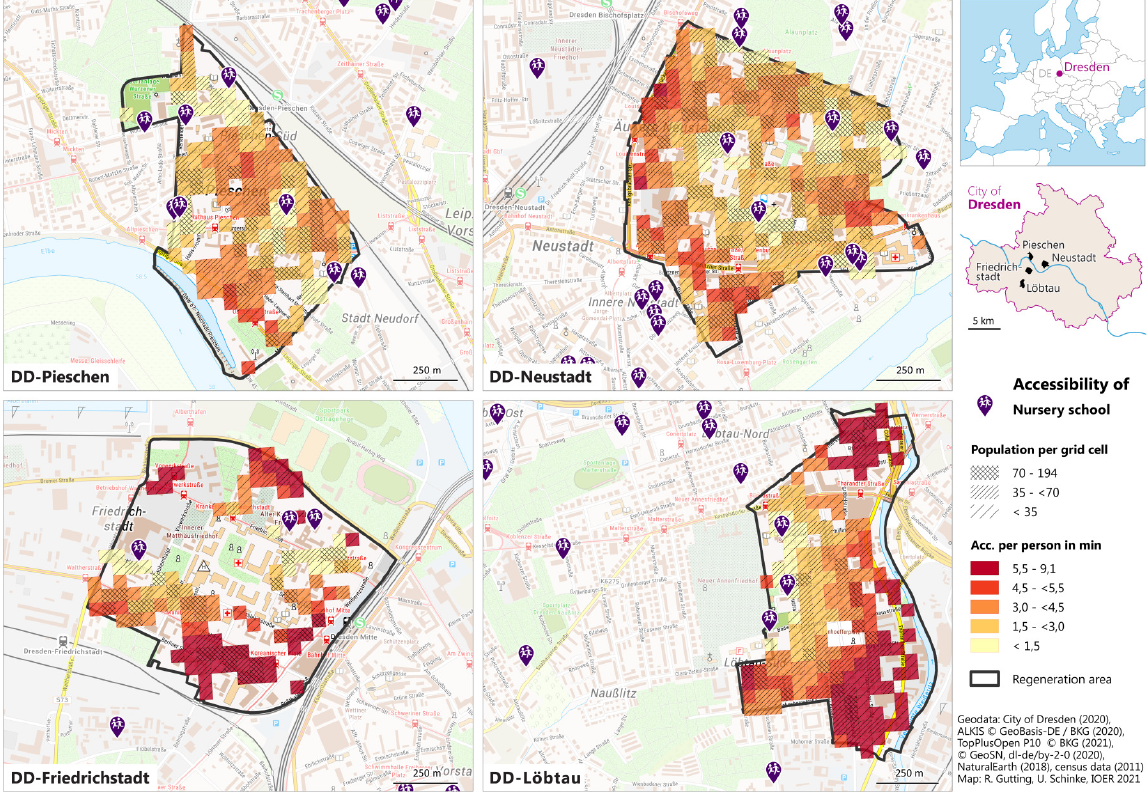
Figure 6. Grid cells showing population density and walking distance in minutes to nearest nursery